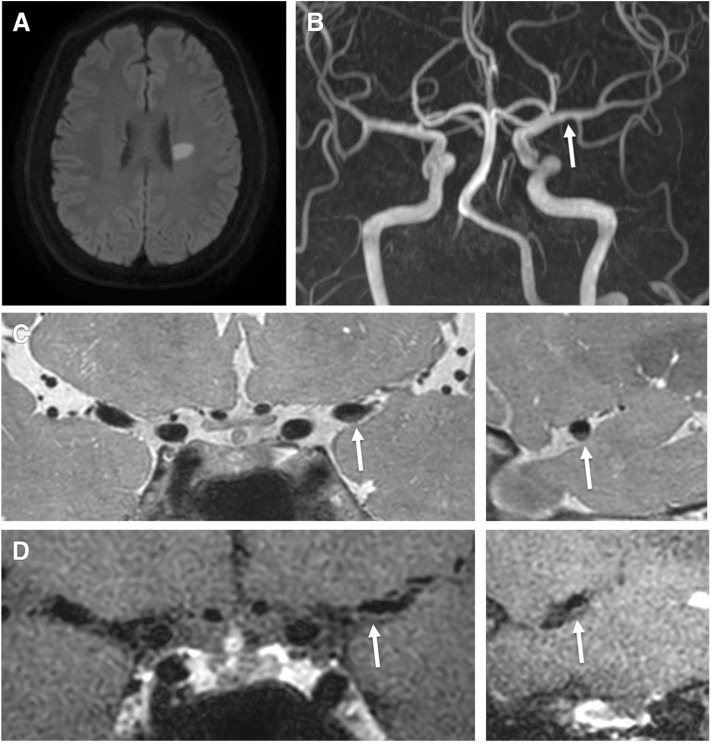
A 62-year-old male patient presented with right hemiparesis with low-density cholesterol, total cholesterol, and Apo (b) levels of 67 mmol/L, 113 mmol/L, 75.5 g/L, respectively. (A) Axial DWI shows a high signal intensity lesion in the left corona radiata region. (B) TOF-MRA shows mild stenosis in the left middle cerebral artery (proximal M1, arrow). (C) Pre-contrast 3-dimensional proton-density black-blood magnetic resonance images. (D) The post-contrast images (left: coronal plane, right: sagittal plane) show eccentric wall thickening (arrow) without enhancement.